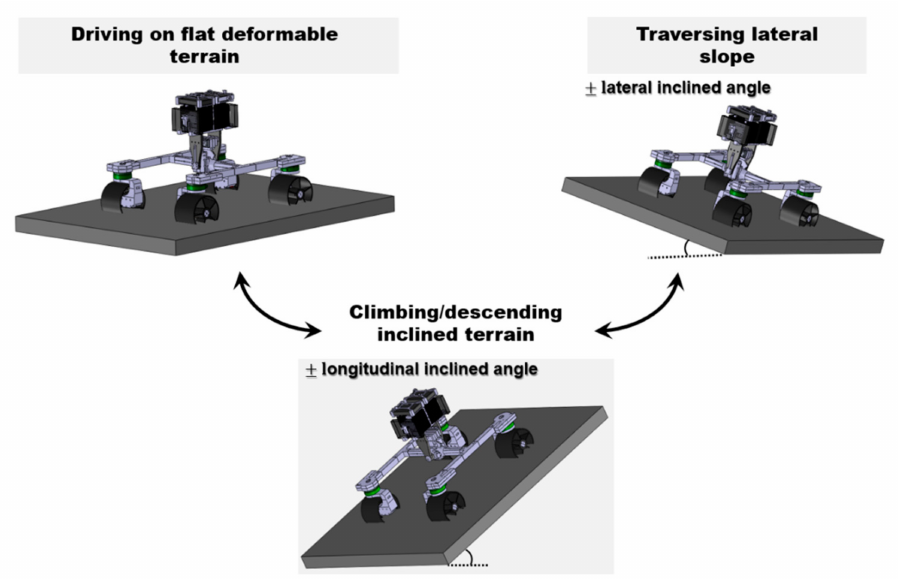
Figure 9. Driving environments during sensitivity analysis and multi-objective optimization and its various dynamic state modes.